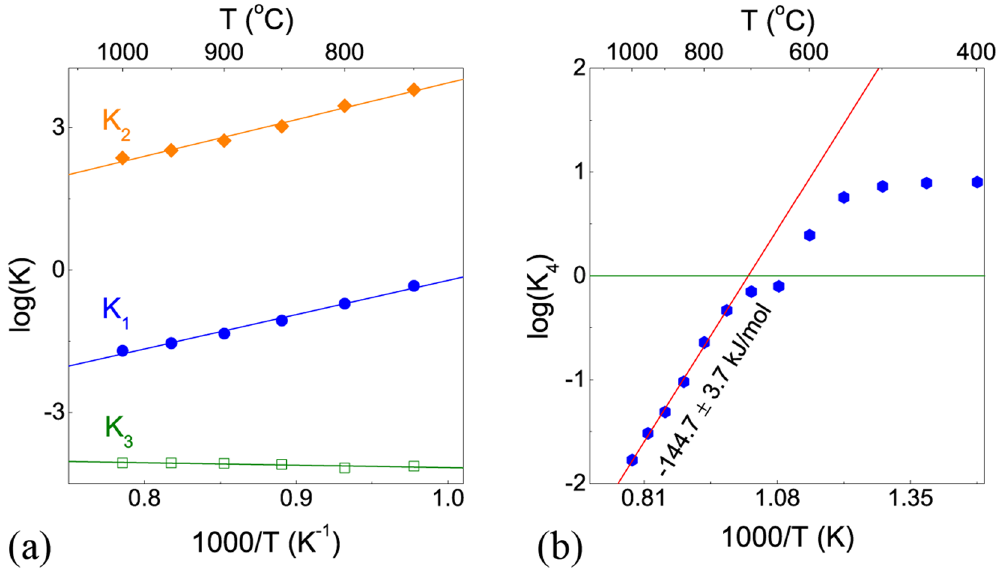
Figure 4. Equilibrium constants ( a ) of K 1 , K 2 , and K 3 reactions and ( b ) of K 4